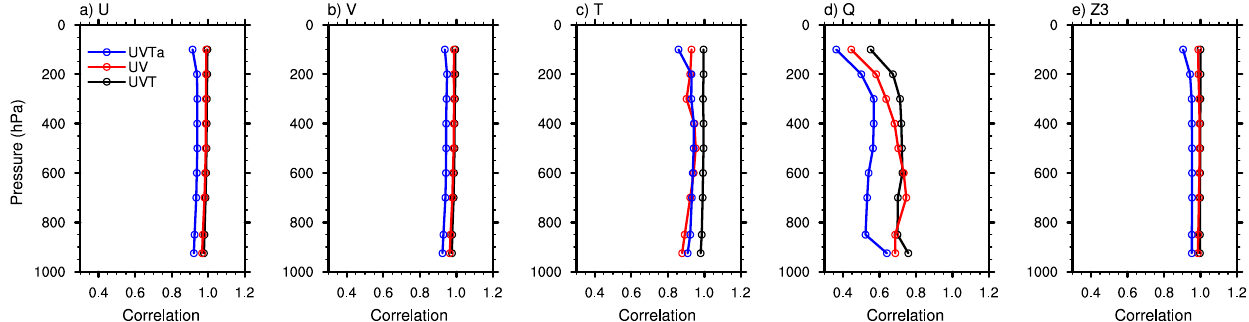
Figure 8. Anomaly correlation between the CAM5 simulated (a)–(b) horizontal winds (U and V), (c) temperature ( T ), (d) specific humidity (Q) and (e) geopotential height (Z3) and the ERA-Interim reanalysis. “UVT” is shorthand for NDG_ERA_UVT (the original method), “UV” for NDG_ERA_UV (wind-only nudging), and “UVTa” for NDG_ERA_UVTa (anomaly nudging). The correlation coefficients were computed from 6hourly instantaneous data on pressure levels, with the corresponding monthly climatology